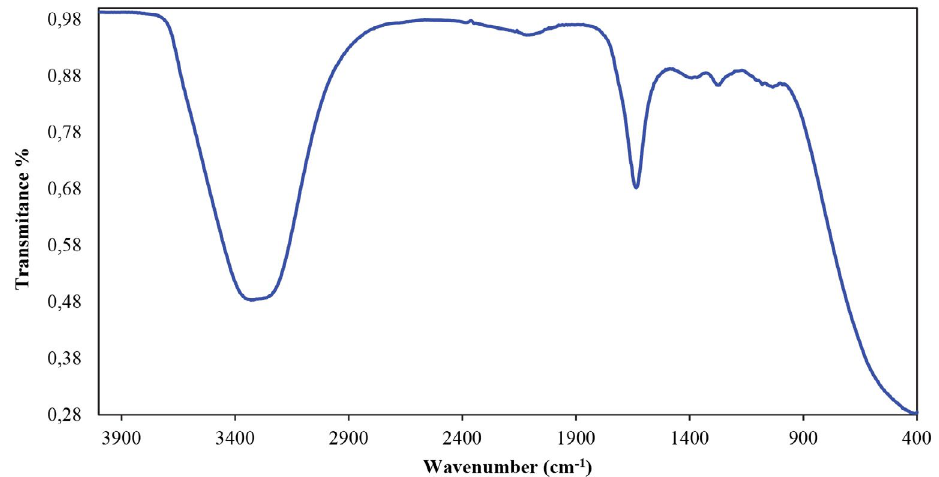
Figure 6. FT-IR study of